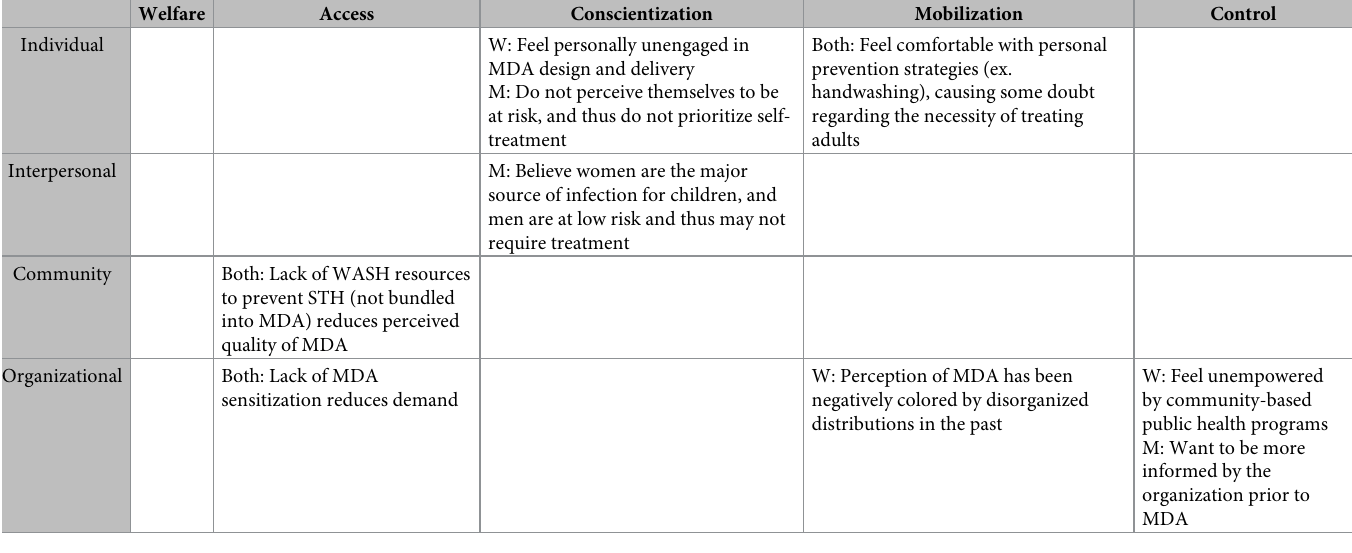
Table 3. Summary of barriers towards participating in the MDA broken down by gender.